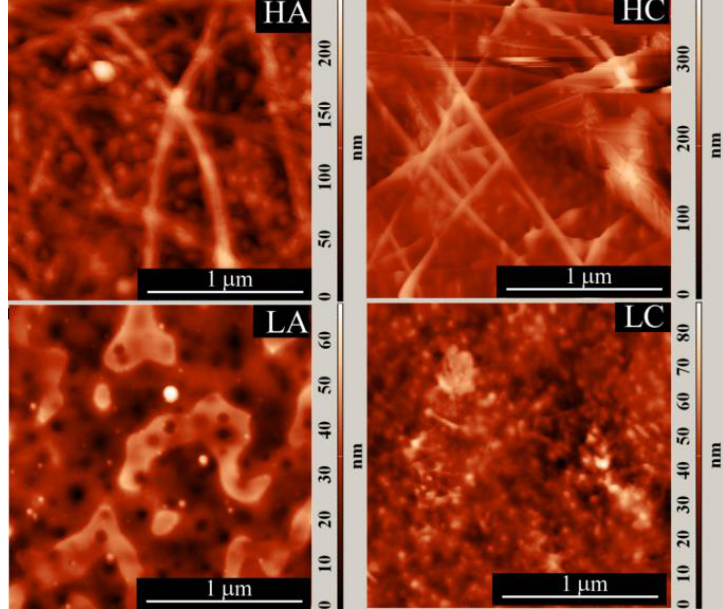
Figure 3. Atomic force microscopy (AFM) images of the studied samples: ( a ) HA; ( b ) HC; ( c ) LA; and ( d ) LC samples.